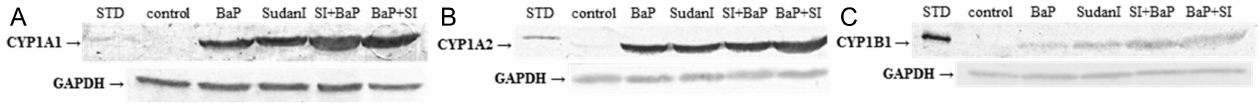
Figure 5. Western blot analysis of CYP1A1 ( A ), 1A2 ( B ) and 1B1 ( C ) in hepatic microsomes isolated from control (untreated) rats and rats exposed to BaP alone, Sudan I alone, Sudan I before BaP treatment (SI + BaP) or Sudan I after BaP treatment (BaP + SI). Glyceraldehyde 3-phosphate dehydrogenase (GAPDH) protein expression was used as a loading control. As a standard (STD) of respective CYP, recombinant rat CYP1A1, rat CYP1A2 or human CYP1B1 in Supersomes™ were